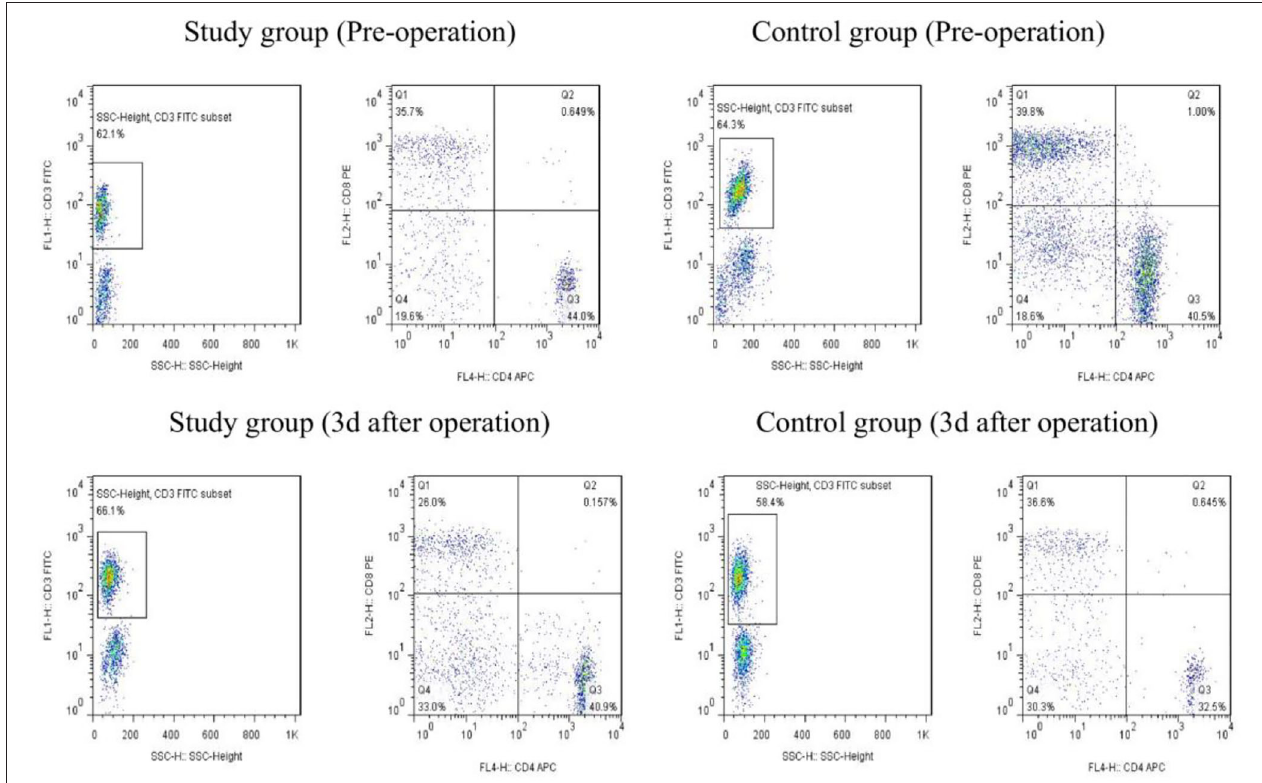
FIGURE 1 | The changes of T-cell subsets (CD4 + and CD8 + ) in the observation group and the control group were detected by flow cytometry before and 3 days after the operation.